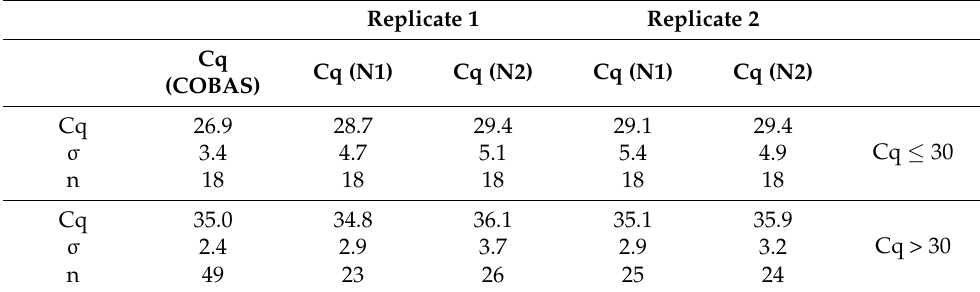
Table 6. Comparison of